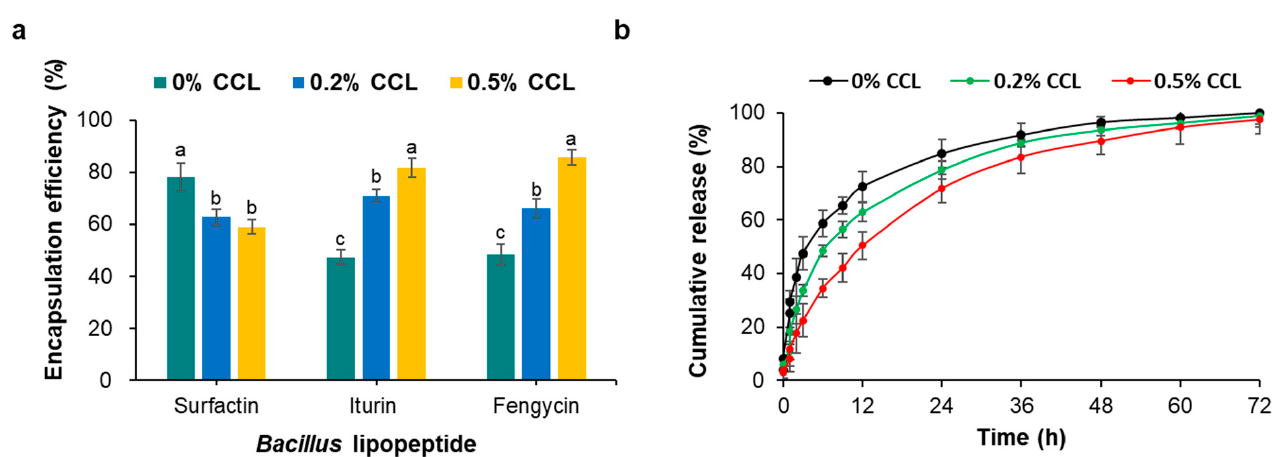
Figure 4. Encapsulation efficiency of CLP-loaded liposomes from CCL products ( a ) and in vitro the CLP release profiles ( b ) at various CS-coated concentration from CCL products. Data represent means ± standard errors of three replicates. The values followed by different letters in a column were significantly different at p < 0.05 by Duncan’s multiple range test.